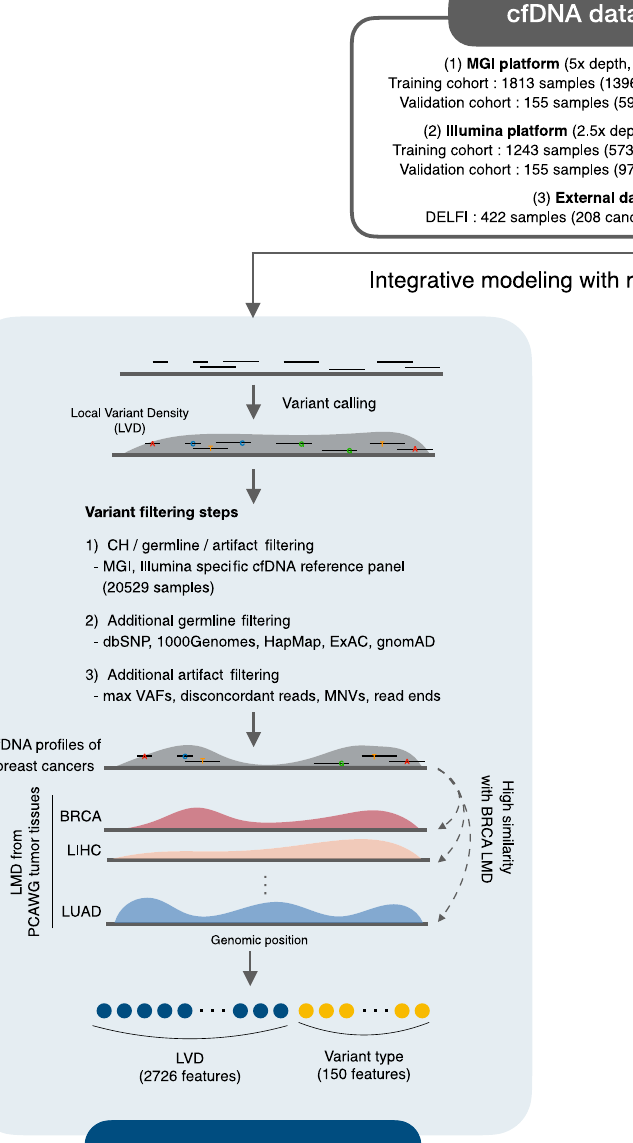
Fig. 1 | Schematic ofthe concept and pipeline ofour models. Schematic of the genome model (left) and epigenome model (right) developed based on the integration of reference tissue data for mutation distribution and chromatin architecture, respectively. For illustration, a breast cancer cfDNA sample is used. For the genome model, various variant fi ltering steps were incorporated. In addition to systematic fi ltering by our healthy cfDNA-based reference panel, additional processes involving public databases and technical methods were employed. The LVD and variant types were obtained from the fi ltered set of variants to be used as input to the genome model. To evaluate LVD patterns,